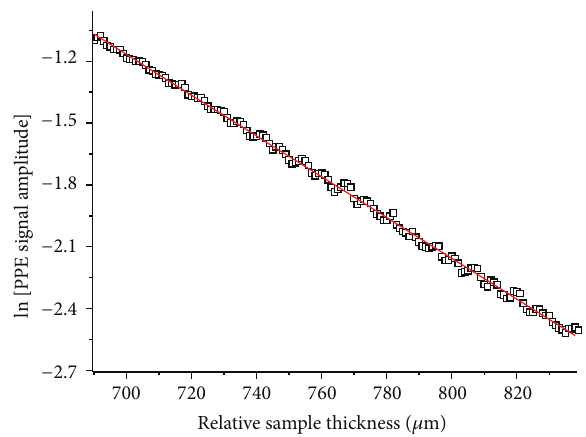
Figure 2: PPE signal amplitude as a function of the cavity length, having water as a sample and PVDF as PE detector; the solid line represents the best fitting of (2) to the experimental data.